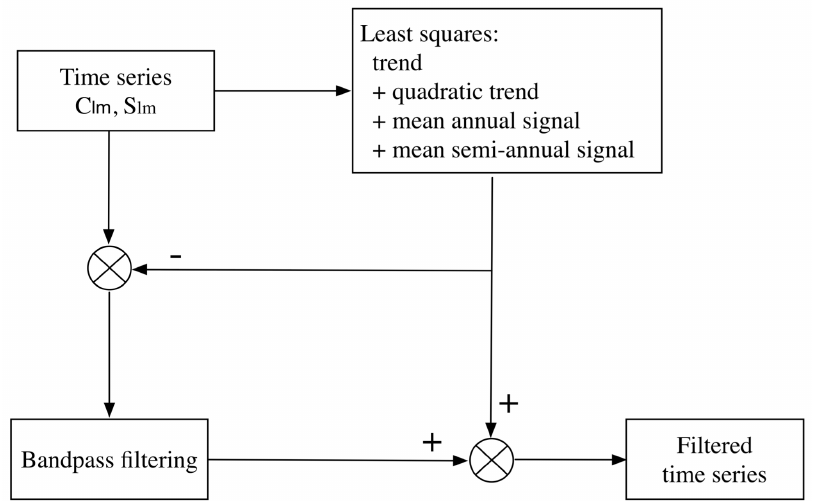
Figure 2. Processing flow of filtering. The mean signals, including trend, quadratic trend, mean annual and semi-annual signals, are removed and restored. Bandpass filtering is implemented on the residual harmonic coefficients to reduce